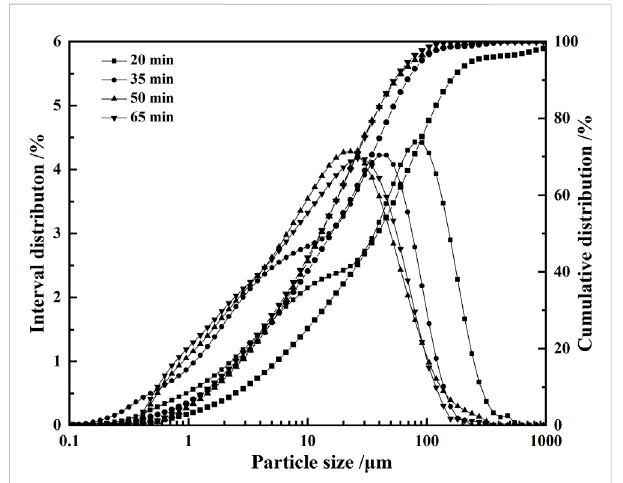
FIGURE 3 Effect of SS content on slump of